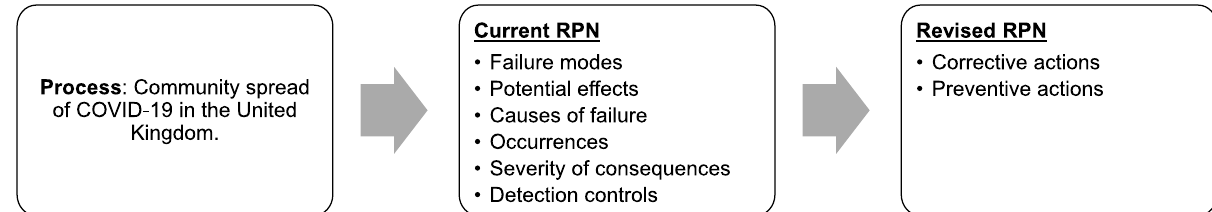
Fig. 3. FMEA mind map for the COVID-19 pandemic in the